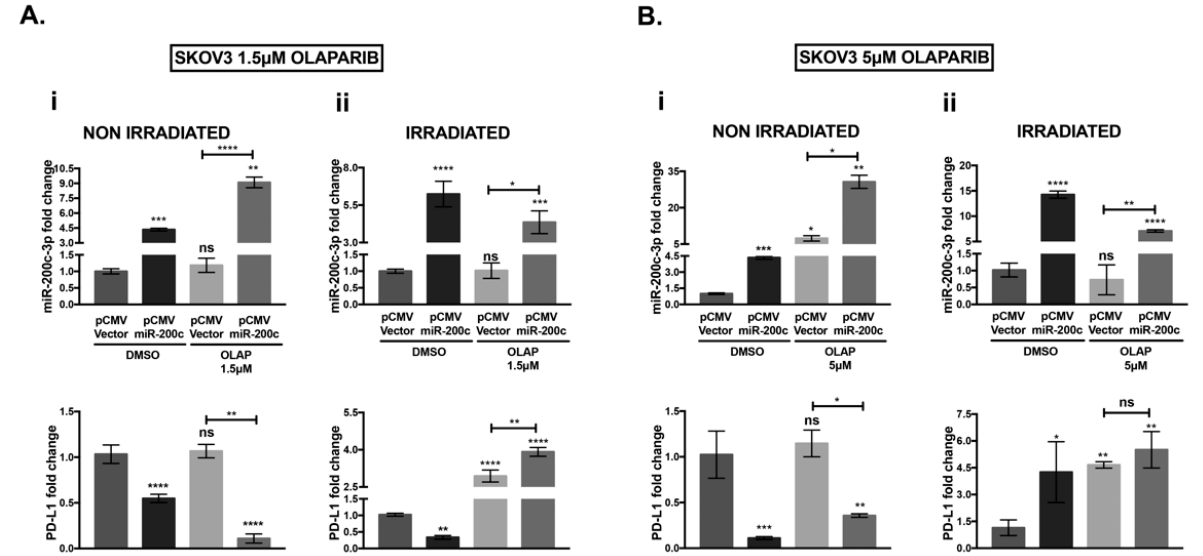
Figure 5. Analysis of miR-200c-3p and PD-L1 expression by RT-qPCR in SKOV3 cells treated with olaparib and irradiation. ( A ) ( i ): Non-irradiated: miR-200c-3p (upper-left graph) is inversely correlated with PD-L1 expression (bottom-left graph) in both DMSO and 1.5 µM olaparib-treated SKOV3 cells, ( A ) ( ii ): Irradiated: In DMSO-treated SKOV3 cells, miR-200c-3p and PD-L1 are inversely correlated. Co-treatment with 1.5 µM olaparib and irradiation shows an increase of PD-L1, regardless of high miR-200c expression. ( B ) ( i ): Non-irradiated: At the higher dose of olaparib, 5 µM, PD-L1 is inversely correlated to miR-200c-3p. ( B ) ( ii ): Irradiated: PD-L1 mRNA is induced in untreated and olaparib 5 µM-treated cells. Experiments were repeated three times and in technical triplicates. p -values were calculated by Dunett’s multiple comparisons: * p < 0.05, ** p < 0.01, *** p < 0.001, **** p < 0.0001, ns: not significant.